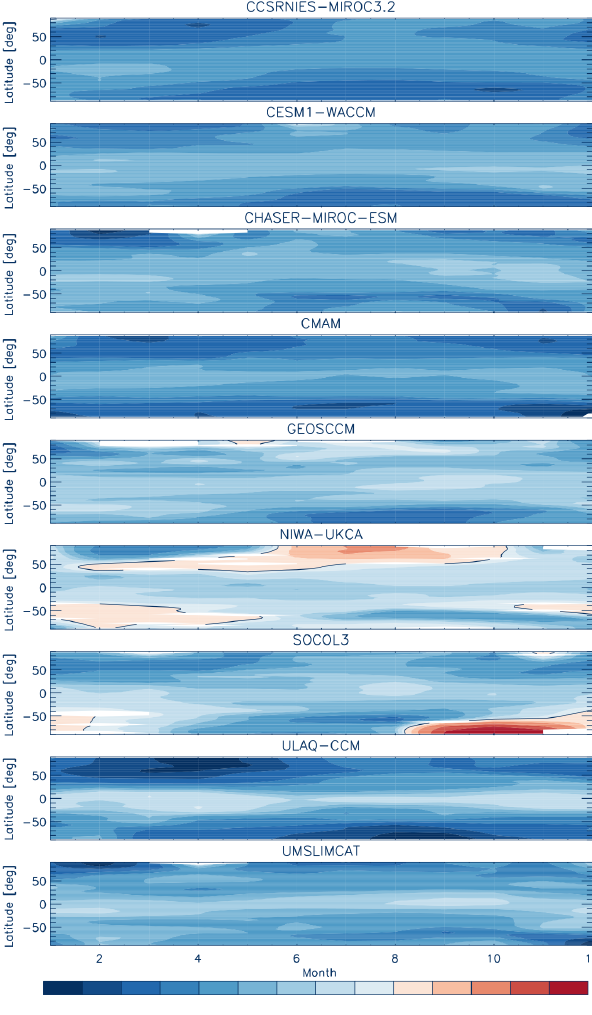
Figure 5. Same as Fig. 2 but for N 2 O, in units of DUppmv − 1 , derived from the REF-C2 and SEN-C2-fN2O simulations.